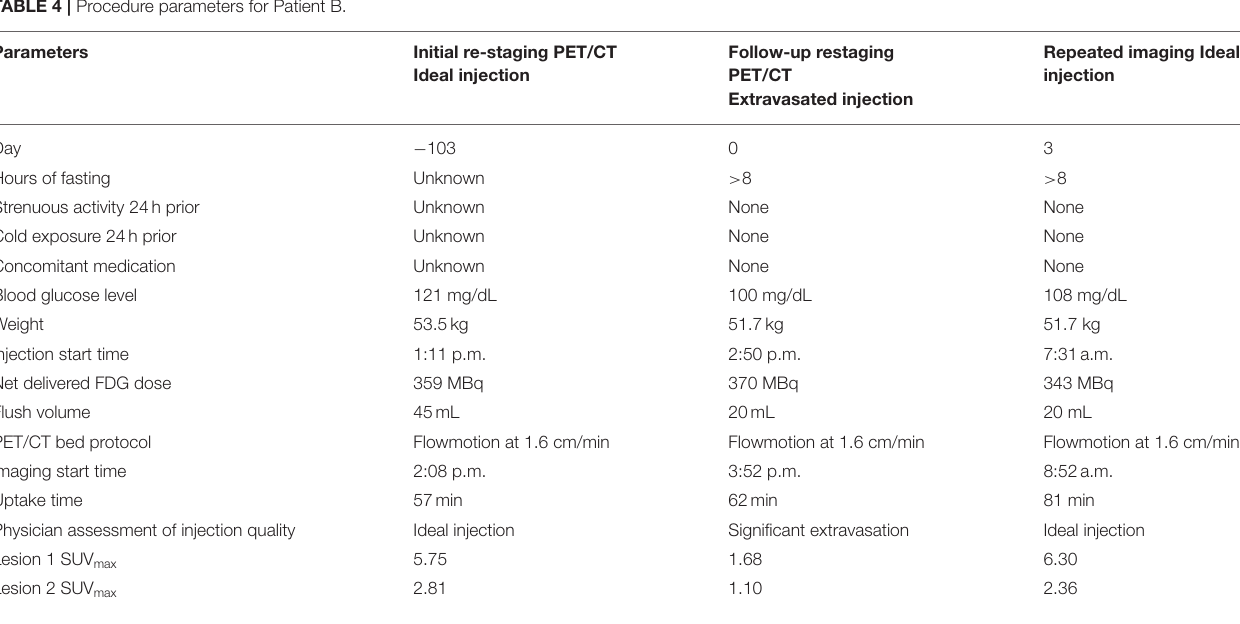
TABLE 4 | Procedure parameters for Patient B.